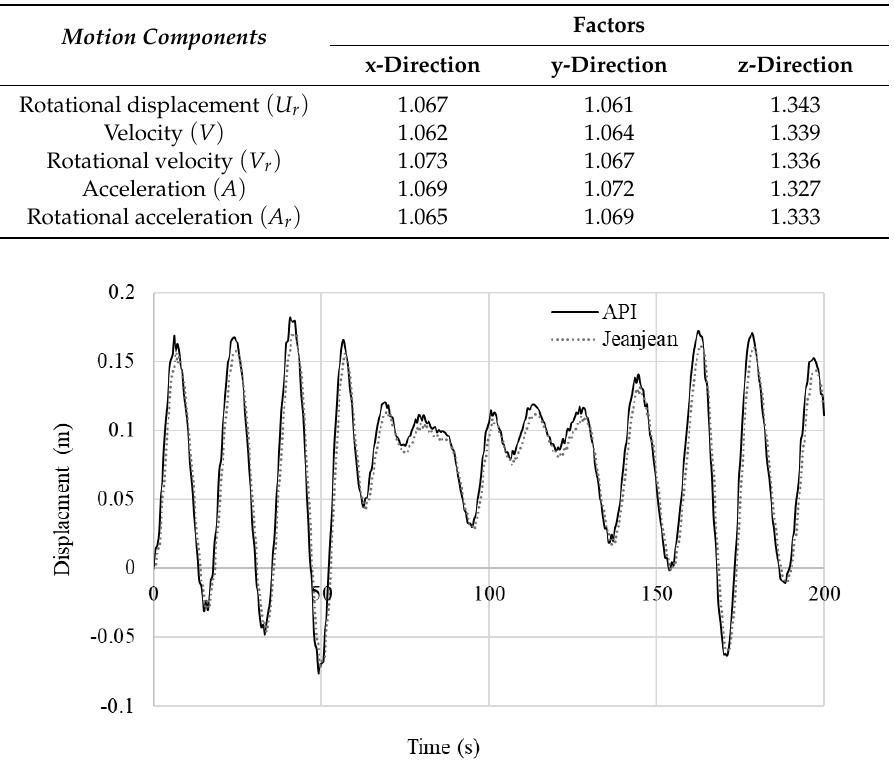
Table 2. Ratio of averaged motion components resulting from the API and Jeanjean methods.